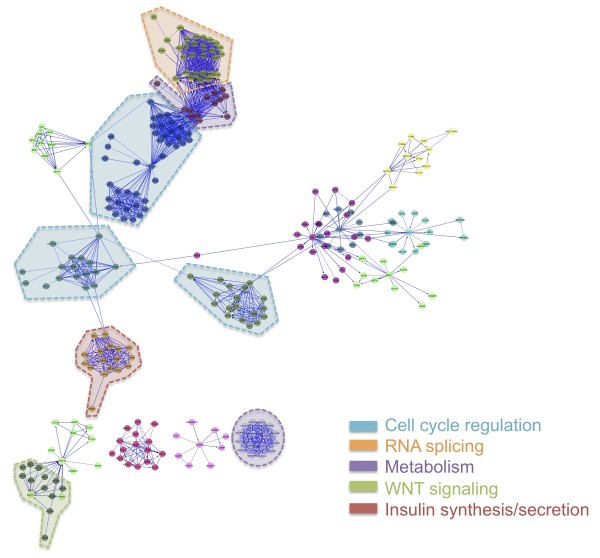
Global functional interaction network. Reactome FI was used to create a functional interaction network, which is divided into modules as defined by node coloring, and further delineated by functional pathway enrichments into outlined, color-coded groups. Major associations among the curated and predicted interactions included cell cycle regulatory, RNA slicing, metabolism, WNT signaling, and insulin-related pathways (FDR <0.01). Network was generated in Cytoscape.